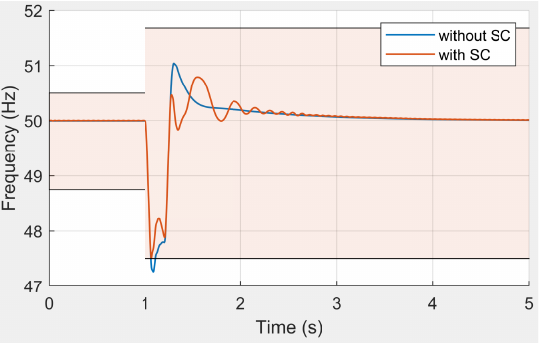
Figure 7. Frequency response comparison during a fault case.